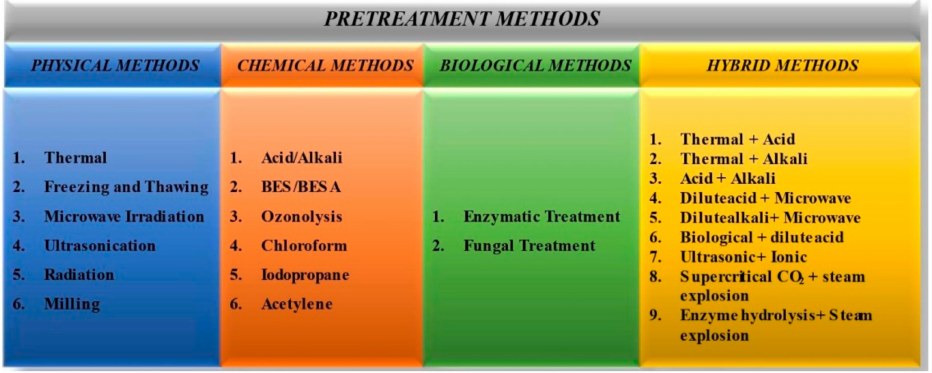
Figure 1. Schematic representation of various pretreatment